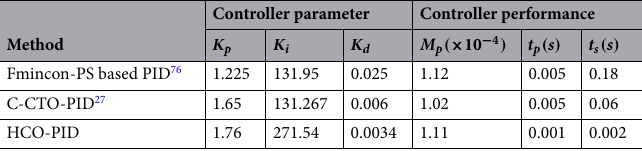
Table 10. Performance comparison of HCO-PID for respiratory ventilator system.